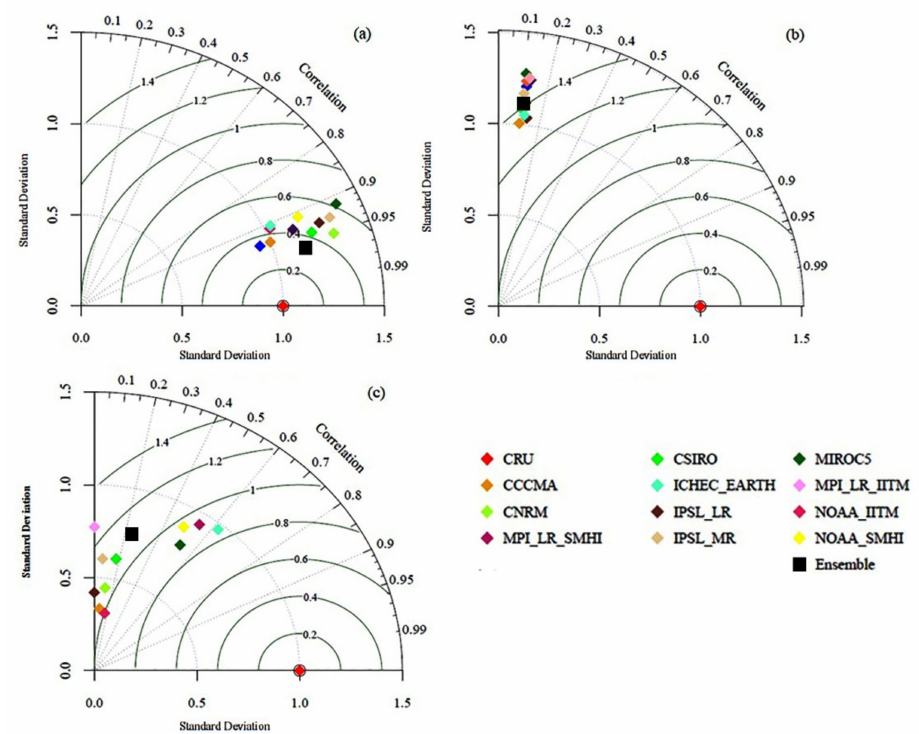
Figure 4. Taylor diagram represents the statistical comparison of normalized ( a ) maximum tempera- ture, ( b ) minimum temperature, and ( c ) precipitation (mm/m) from 1976 to 2005 of CORDEX-SA models, their ensemble, and CRU